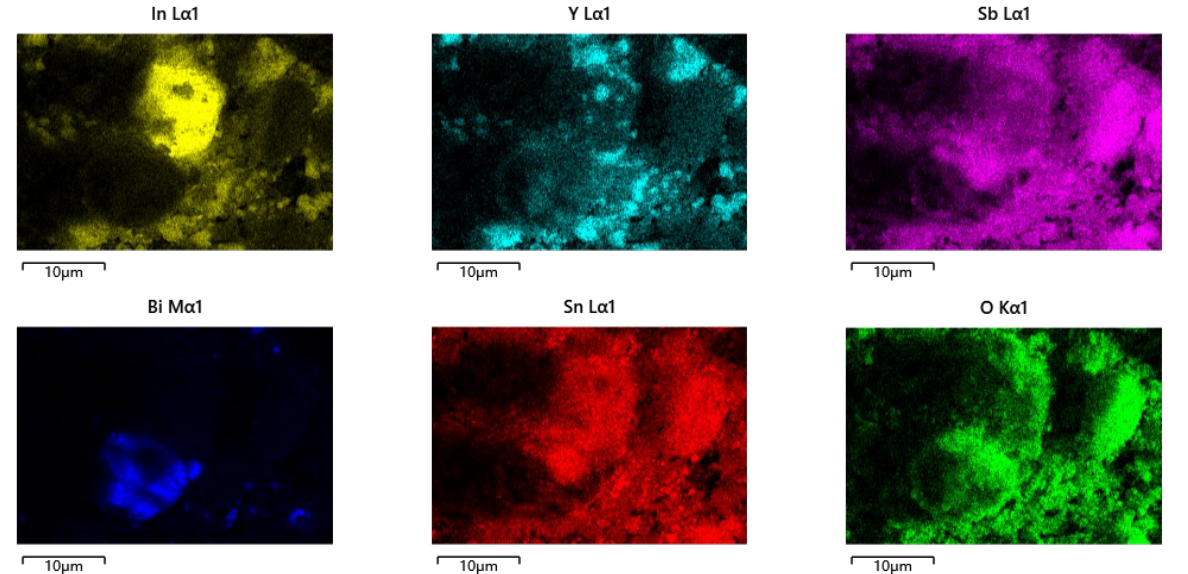
Figure 12. SEM photograph of IBHP.